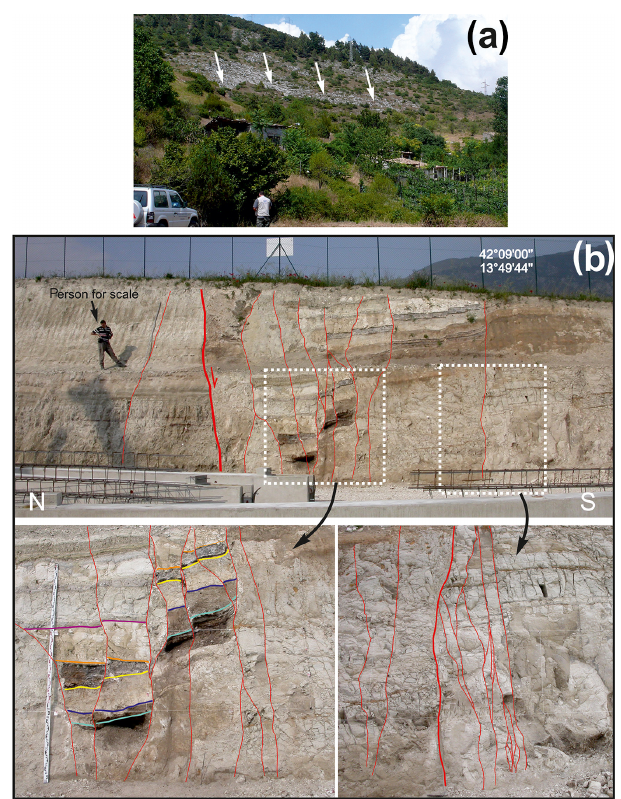
Figure 6. (a) Discontinuous bedrock fault scarp of the Avezzano– Bussi fault along the northern border of the Sulmona Basin. (b) Transtensional faults in the Sulmona Basin, aligned along one of the splays of the Avezzano Bussi fault, displacing Early Pleistocene lacustrine